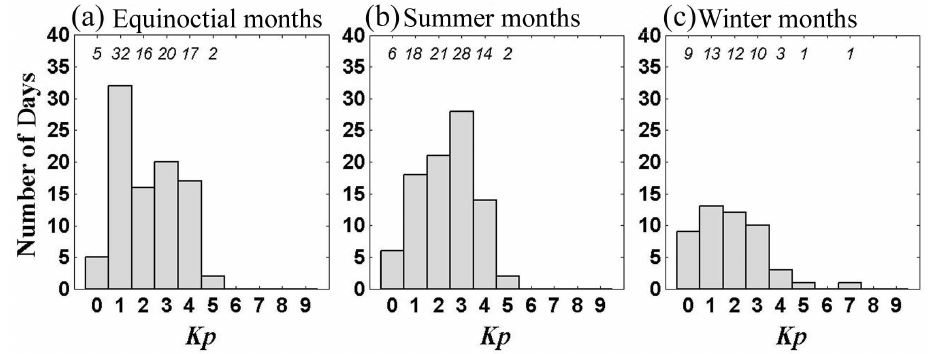
Fig. 7. Occurrence of ESF on each day for each of the equinoctial (a) , summer (b) , and winter (c) months plotted as a function of K p determined as the average during the 6h prior to